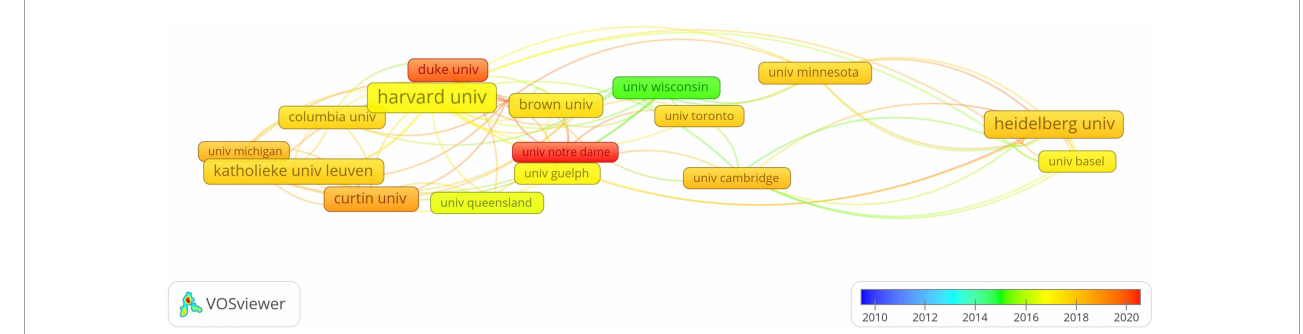
FIGURE4 The overlay visualization of institutions generated by VOSviewer. The color of the nodes and lines indicated corresponding average appearing year of institution.